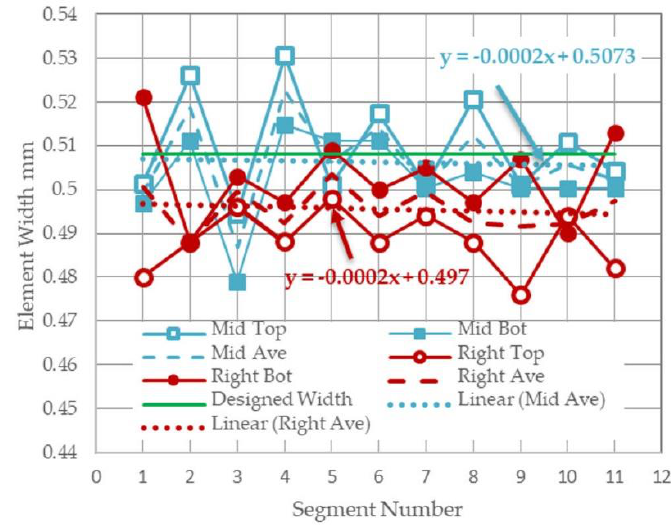
Figure 27. Element width measured at mid-span and right end of single-sheet flexure cut with Zund.